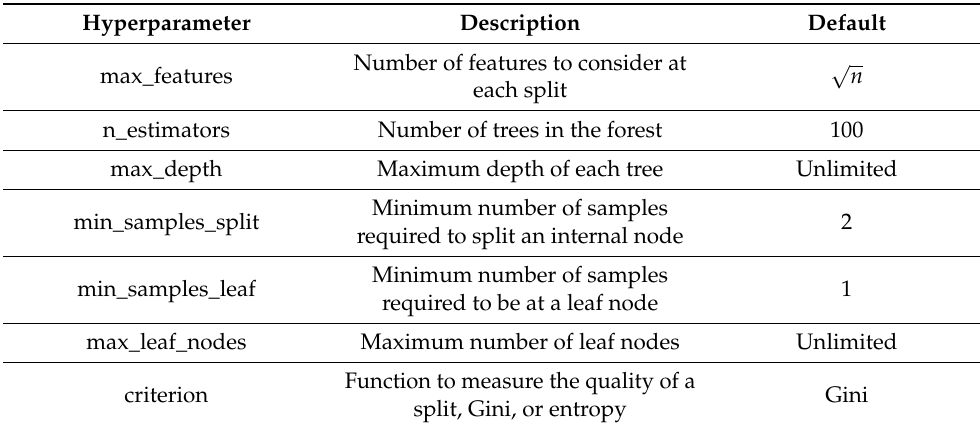
Table 2. Overview of the different hyperparameters of the standard random forest classifier module. The number of features is represented by n .